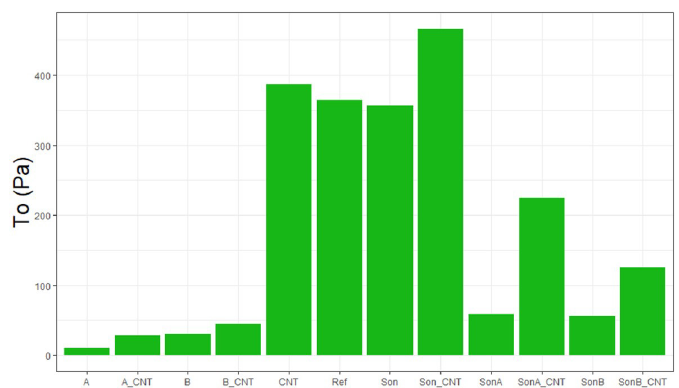
Figure 7. Static yield stress of the fresh Portland cement pastes.